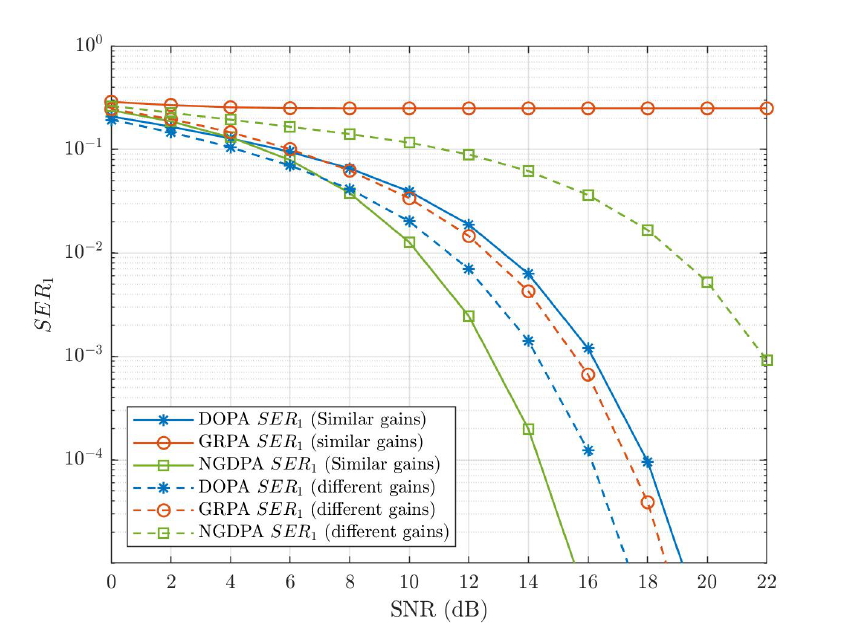
Figure 9. Theoretical and simulated SER of two users in a NOMA − based VLC system.